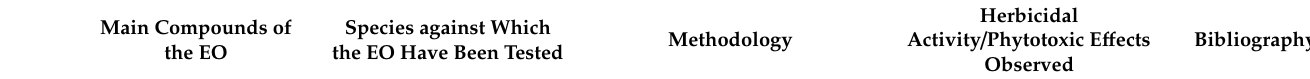
Table 1. Reported herbicidal activity of essential